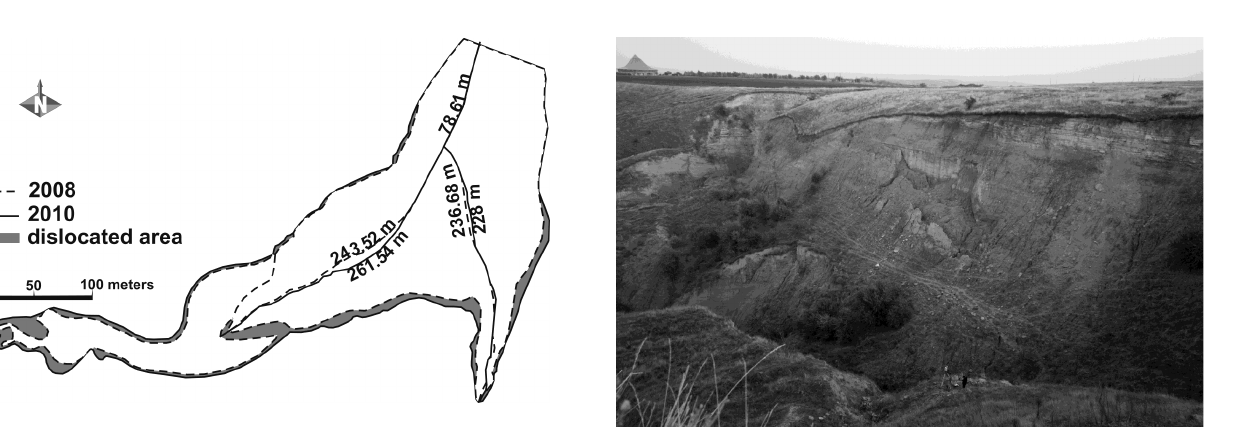
Fig. 19. The Cucuteni-Baiceni Gully